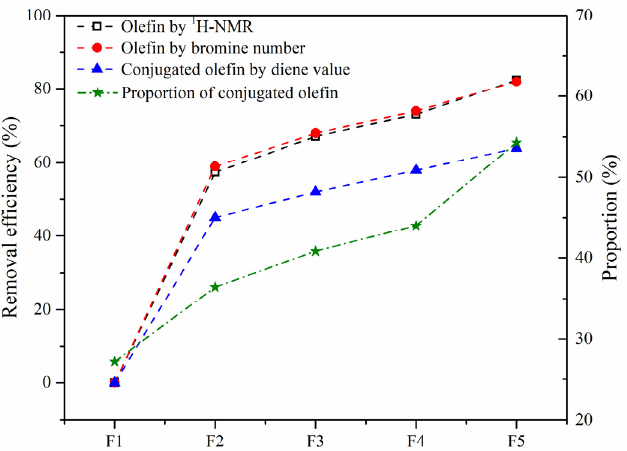
Figure 11. Removal efficiency of olefins in the SLO. The feed FCC slurry oil is designated as F1; FCC after reaction with non-catalyst is designated as F2. FCC after reaction with A-MoS 2 is designated as F3; FCC after reaction with M-MoS 2 is designated as F4; FCC after reaction with Mo 2 C is designated as F5.